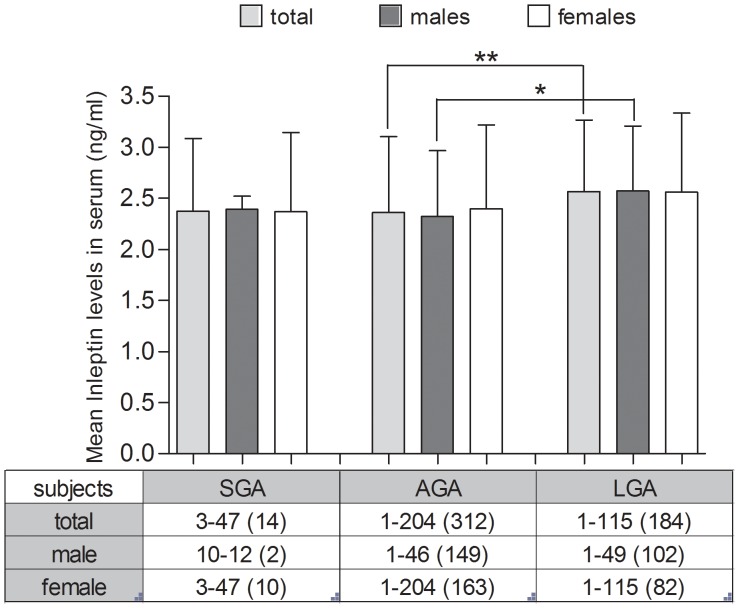
Cord blood (ln)leptin levels in SGA, AGA and LGA neonates.Values show mean ± SD. Statistically significant differences are indicated by asterisks (*, P<0.05; **, P<0.01, compared with the Kruskal-Wallis test). The table shows the min. and max. values (ng/ml) and the number of subjects (n) per group (total, males, females).